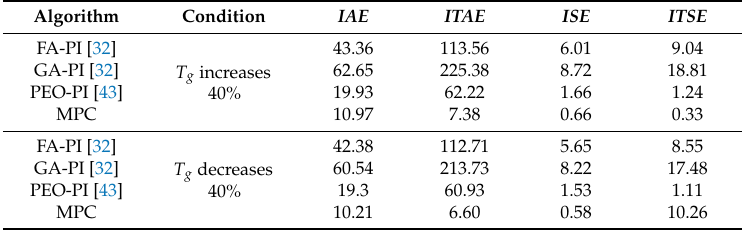
Table 6. Performance comparison of MPC, PEO-PI, GA-PI and FA-PI for case 3. Algorithm